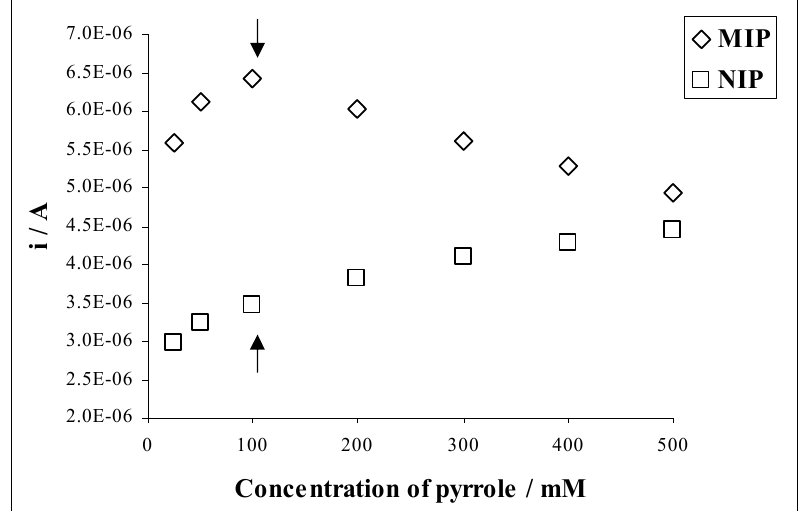
Figure 8. Effect of the monomer concentration on ( ∆ ) MIP and ( □ ) NIP electrodes for 0.10 mM sulfamethoxazole in 50% (v/v) acetonitrile-water Britton-Robinson buffer at pH 2.5.